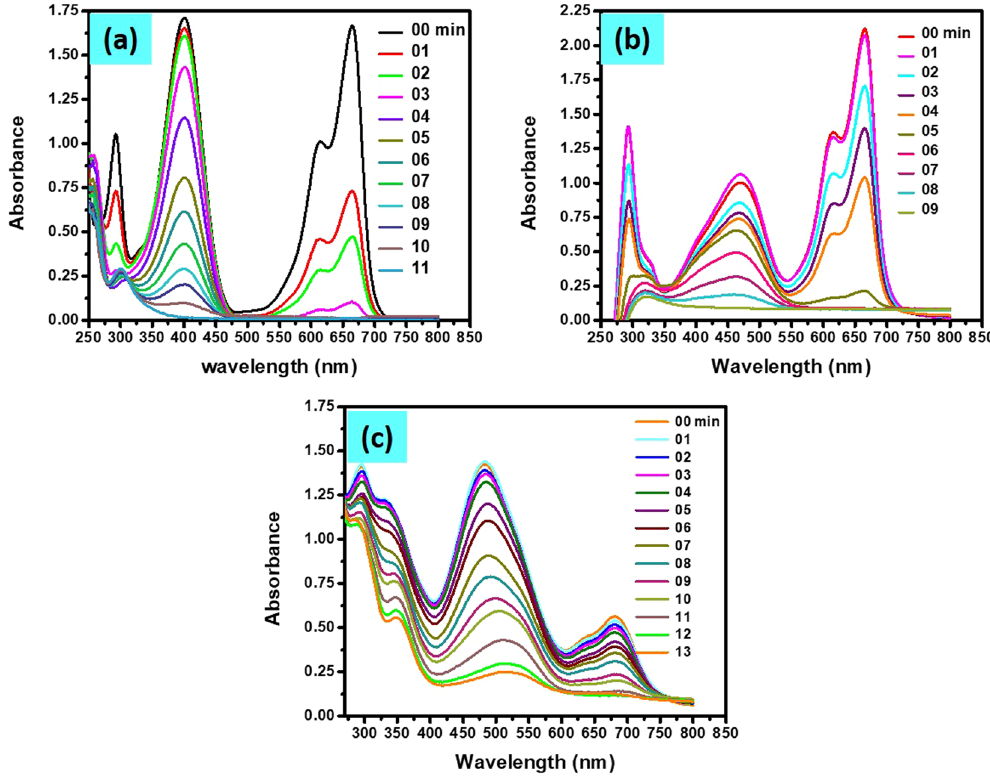
Figure 12. UV-vis spectra of catalytic reduction of mixed solution of 0.1 mM concentration of each 4-NP with MB ( a ), MO with MB ( b ) and CR with MB ( c ) as a function of time by NaBH 4 in the presence of Cu/CS-TiO 2